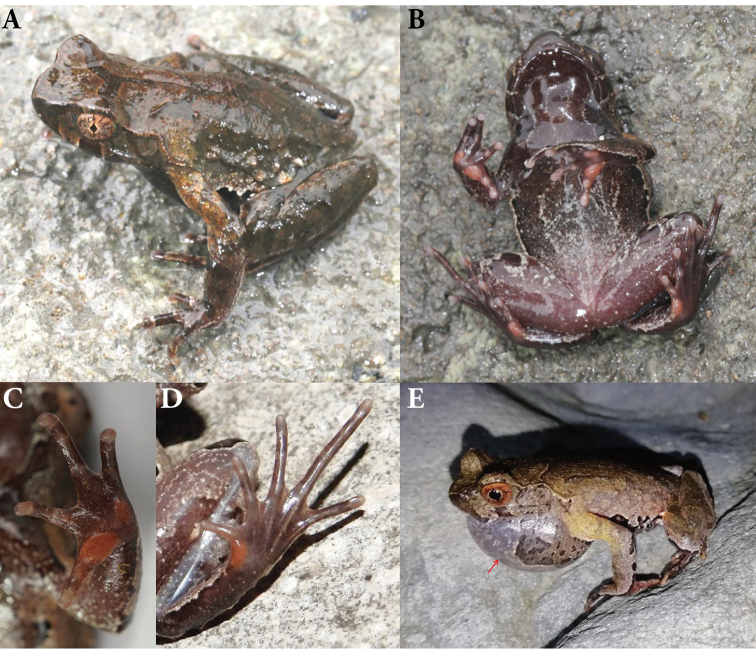
Photos of the holotype CIBXJ190503 of Megophrys
xianjuensis sp. nov. in life A dorsal view B ventral view C ventral view of hand D ventral view of foot E dorsolateral view showing the single external subgular vocal sac (red arrow).